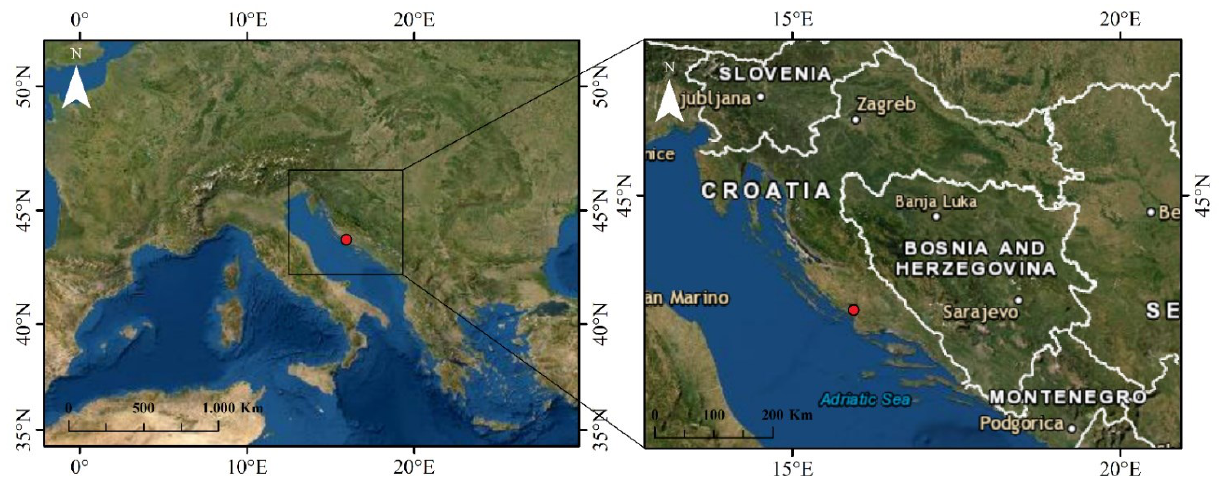
Figure 1. The study area (red dot shows the location of the